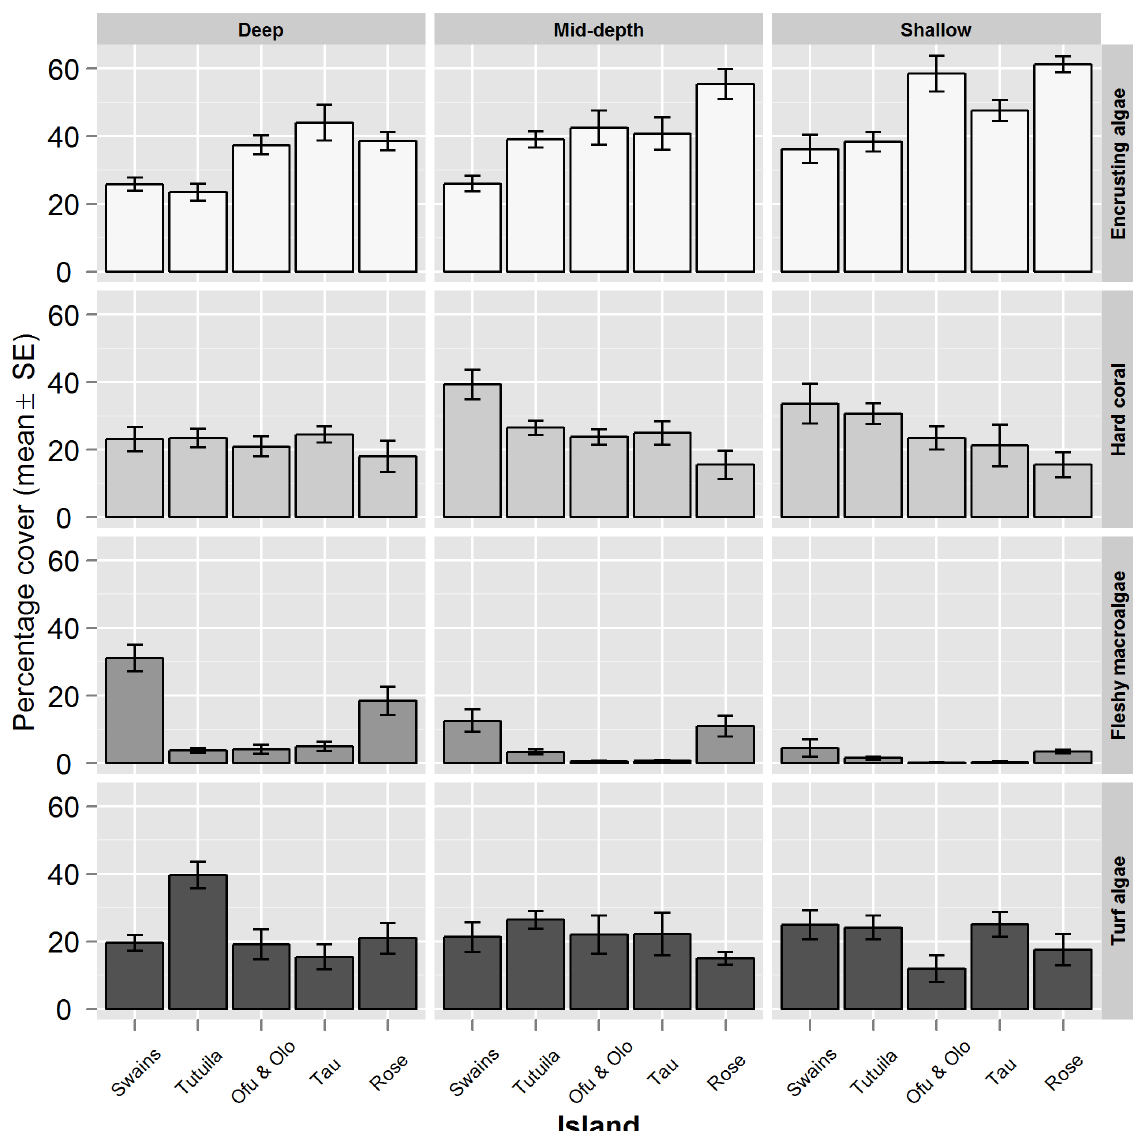
Figure 2. Variation in the benthic composition around islands in American Samoa by depth zone. The mean percentage cover (standard error (SE) bars) of encrusting macroalgae, hard coral, fleshy macroalgae and turf algae. Mean cover was calculated by pooling sites surveyed per depth zone per island. Depth zone ranges were shallow: 0–6-m, mid-depth: 6–18-m and deep: 18–30-m).